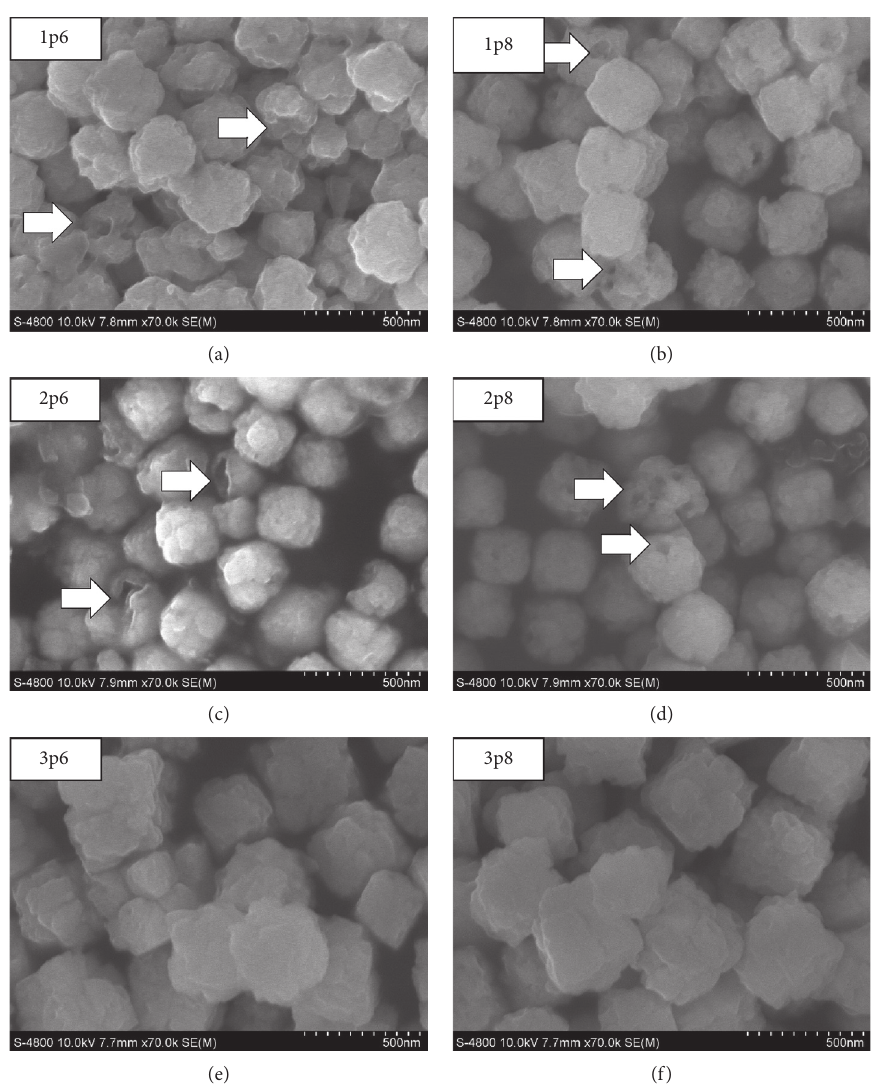
Figure 3: FE-SEM micrographs of Cu 2 O samples at 500nm scale (70,000x magnification): (a) 1 p 6, (b) 1 p 8, (c) 2 p 6, (d) 2 p 8, (e) 3 p 6, and (f) 3 p